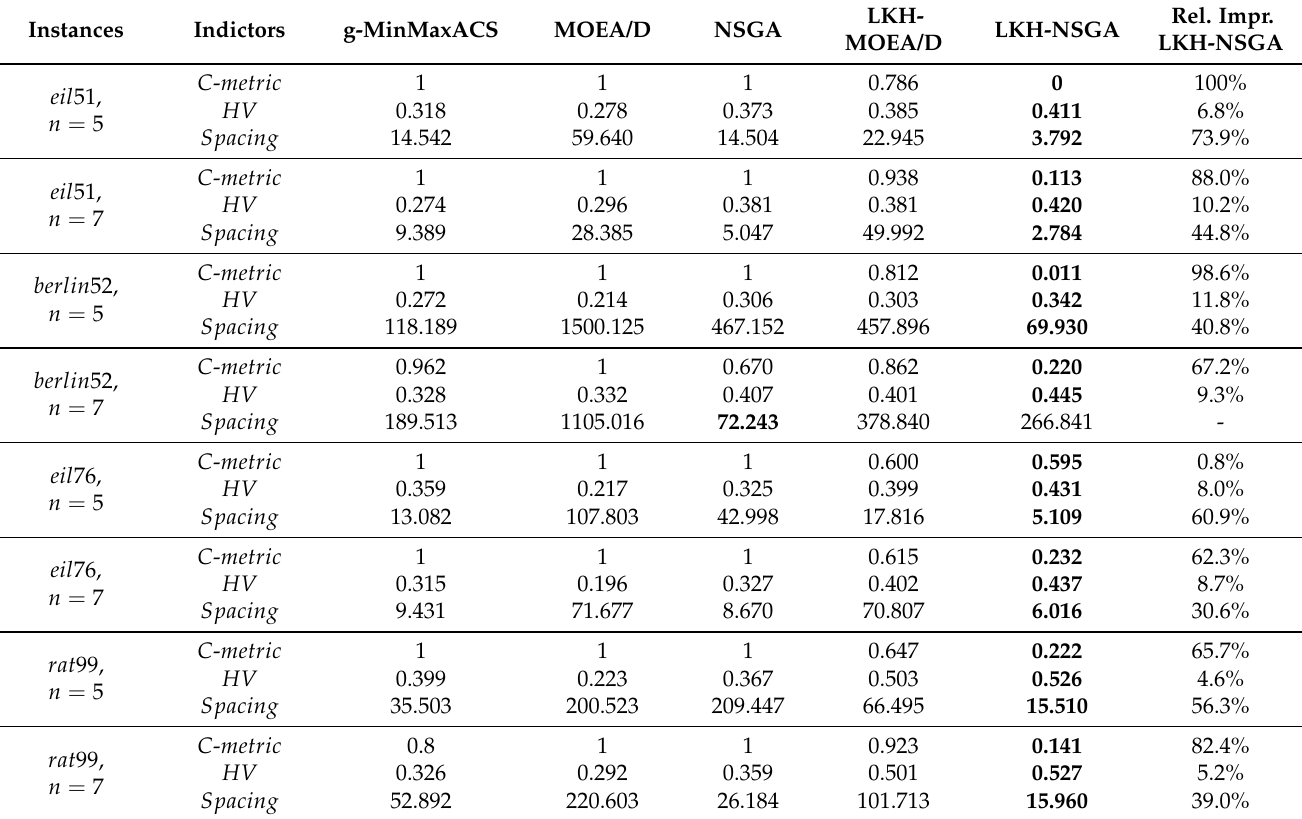
Table 1. The performance of different